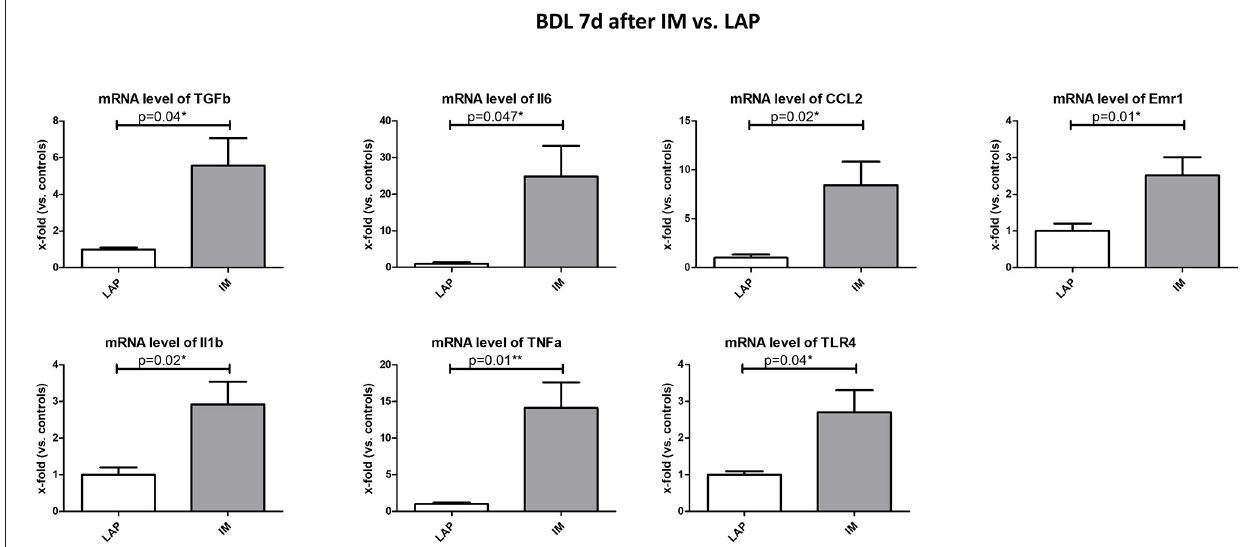
FIGURE 4 | Analysis of parameters of hepatic inflammation (TGFb, IL-6, IL-1b, TNF-alpha, Emr1, TLR-4) in the BDL group 7 days after IM vs. LAP, all significantly elevated. Levels of gene expression are shown as x-fold compared to the respective control group. * p ≤ 0.05; ** p ≤ 0.01; ns. (p > 0.05).